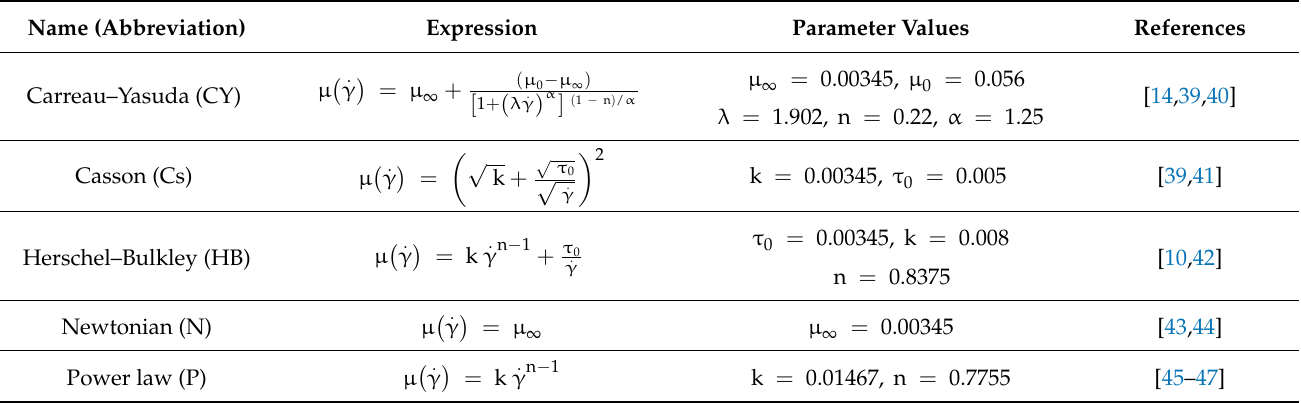
Table 2. Rheology models and parameter